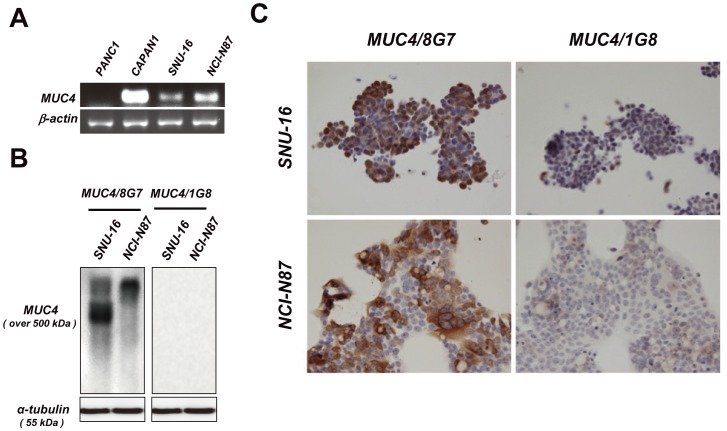
The difference in antibody specificity between anti-human MUC4 monoclonal antibodies (MAbs), 8G7 and 1G8.A: MUC4 mRNA was detected in the two gastric cancer cell lines, SNU-16 and NCI-N87. PANC1 and CAPAN1 cells were used as a negative and positive control, respectively. B: Cell lysates of SNU-16 and NCI-N87 were immunoblotted and detected by the indicated antibodies, respectively. A-tubulin served as a loading control. C: Formalin-fixed SNU-16 and NCI-N87 cells were processed for immunocytochemistry using the MAbs, 8G7 and 1G8, respectively. Original magnification ×400.